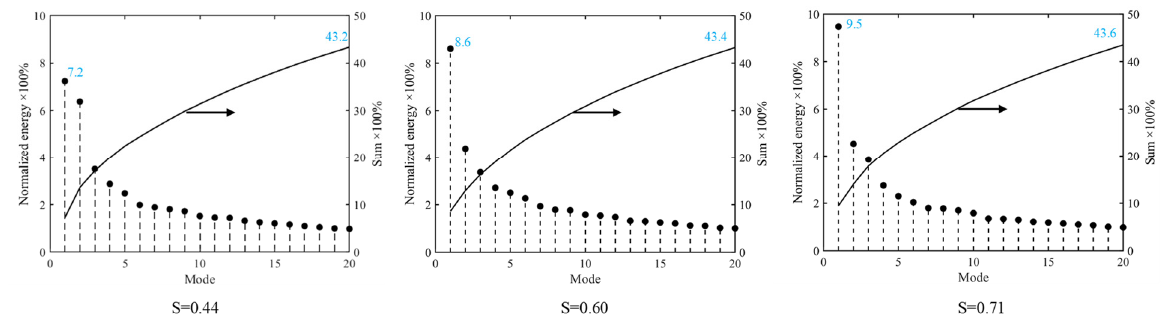
Figure 10. Energy distributions of POD modes.